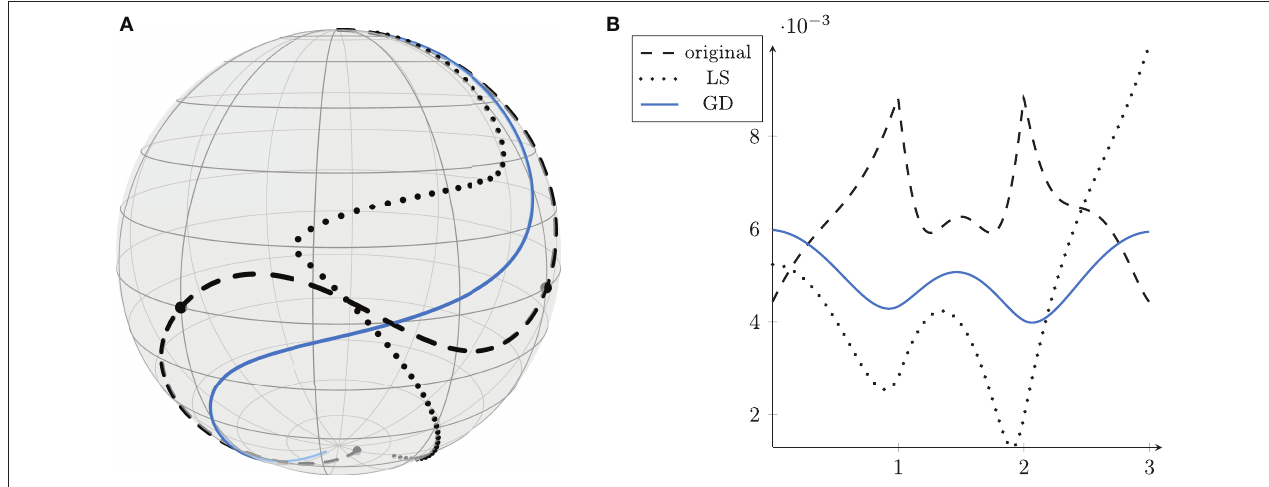
FIGURE 10 | The initial composite Bézier curve on S 2 (dashed, A ) has an MSA of 10.9103. The curve obtained with the linear system (LS, dotted) of [37] has an MSA of 7.3293. The solution returned by our proposed method (GD, solid blue) outperforms them all with an MSA of 2.7908. This is further illustrated by the first order derivative approximated by first order differences in (B)